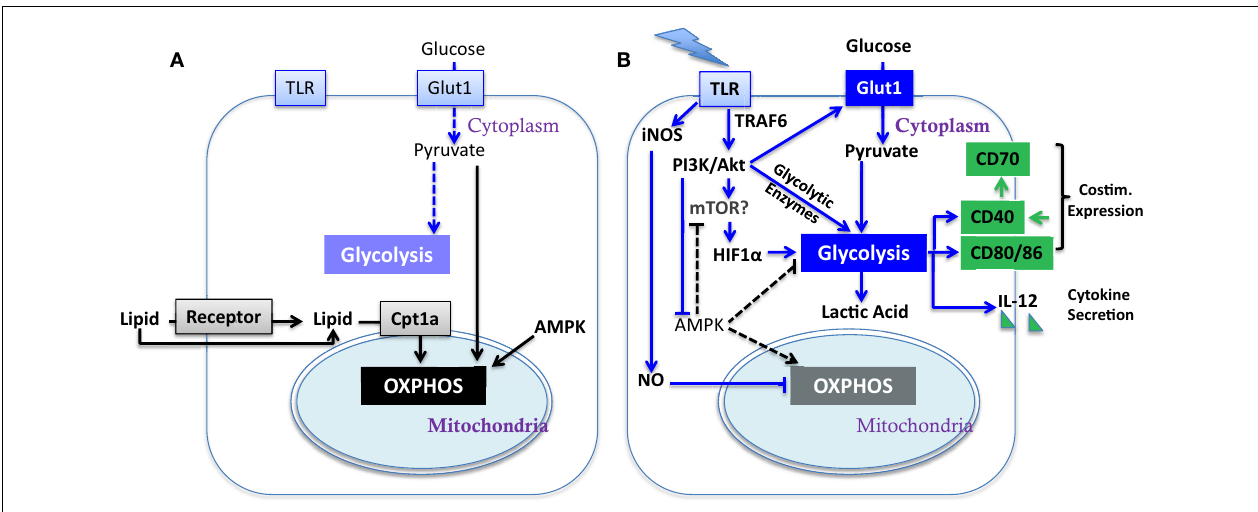
which contributes to their activation (major determinants in green; costim. is short for co-stimulatory molecule). Block arrows mark blockade and dash lines show insignificant process.The impact of mTOR on glycolysis has yet to be fully elucidated in DC (see Section “AKT and mTOR in DC Function” in